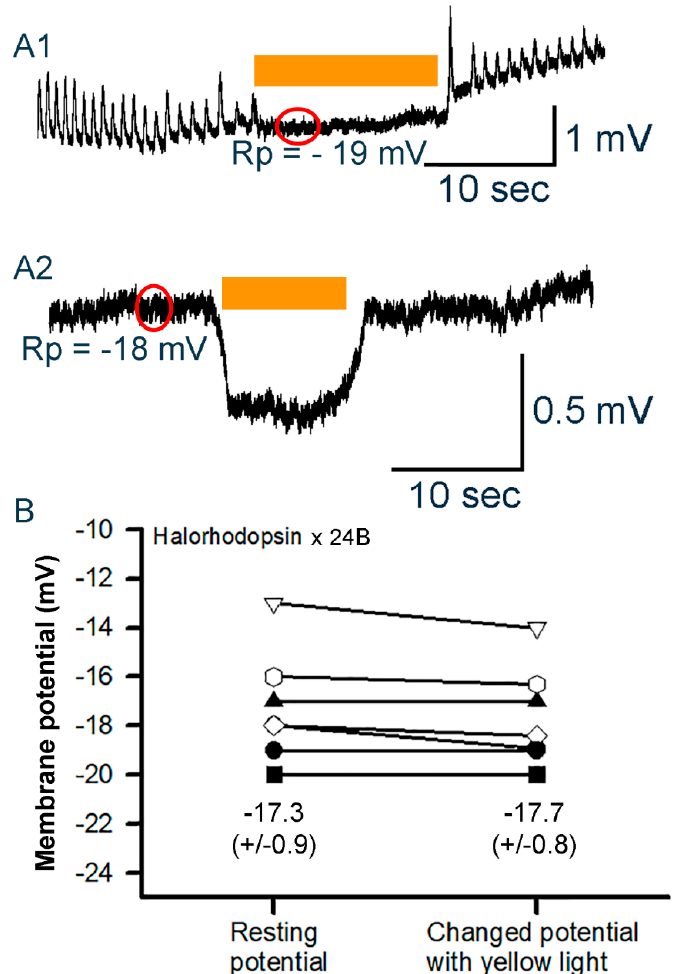
Figure 9. Membrane potential changes in heart muscle in 3rd instar larvae for the halorhodopsin (eNpHR)-expressing line. ( A1 ) When halorhodopsin is activated by yellow light, the heart stopped beating without the membrane hyperpolarizing. ( A2 ) This preparation shows a sustained hyperpolarization during the yellow light pulse. ( B ) The changes in membrane potential from resting condition to peak response hyperpolarizing potentials during the light pulse are shown for each preparation. The circles overlaying on the trace indicate where the membrane potential is measured. Mean ( ± SEM) values are presented next to each distribution.